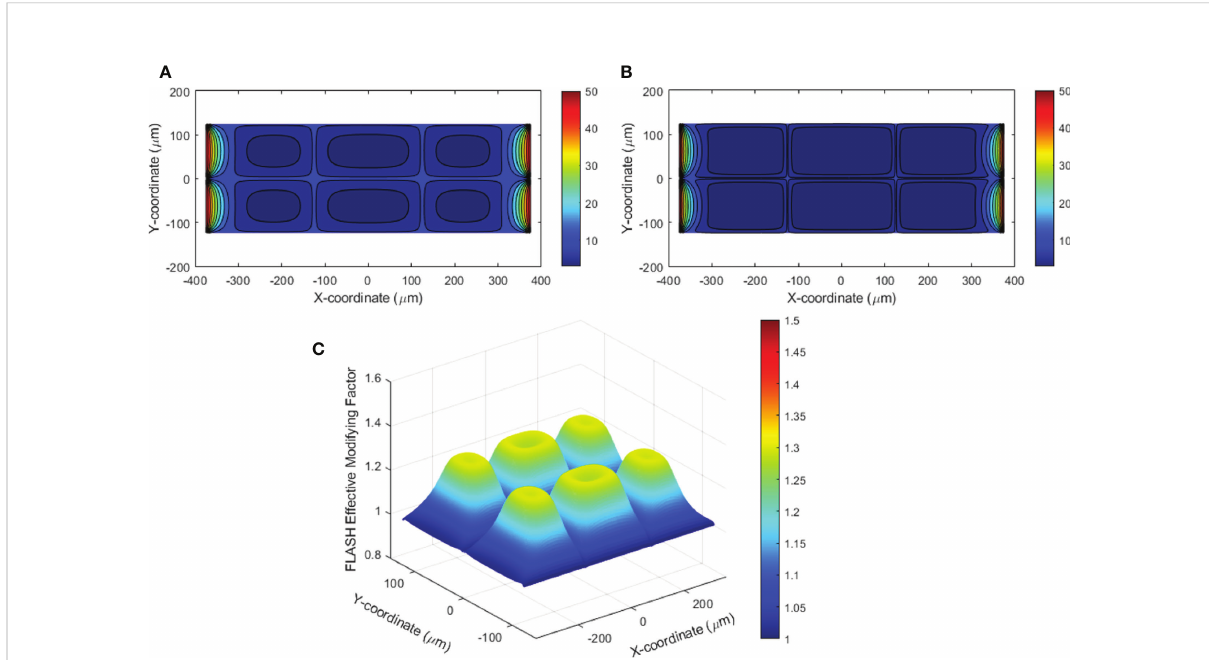
FIGURE 8 (A) Contour plot of the oxygen distribution in the simulated 2D region prior to irradiation; (B) contour plot of the oxygen distribution after UHDR irradiation of 10 Gy at 285 Gy/s; (C) FLASH effective-dose-modifying factor (FEDMF) comparing the CONV and FLASH effective dose using the hypoxic reduction factor model.